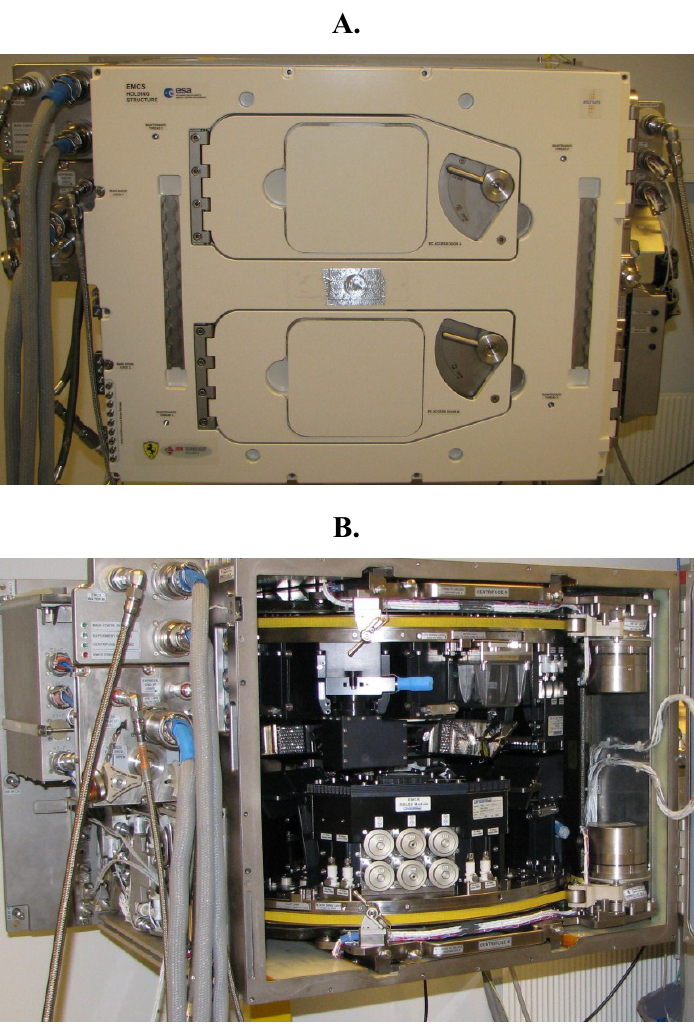
Figure 2. The EMCS Flight Module seen from the front side ( A ) with two doors behind which there are two identical rotors (centrifuges). In ( B ), where the doors are open, a detailed view of the inside of the EMCS is shown. For more detailed descriptions of the EMCS please see [48–52].